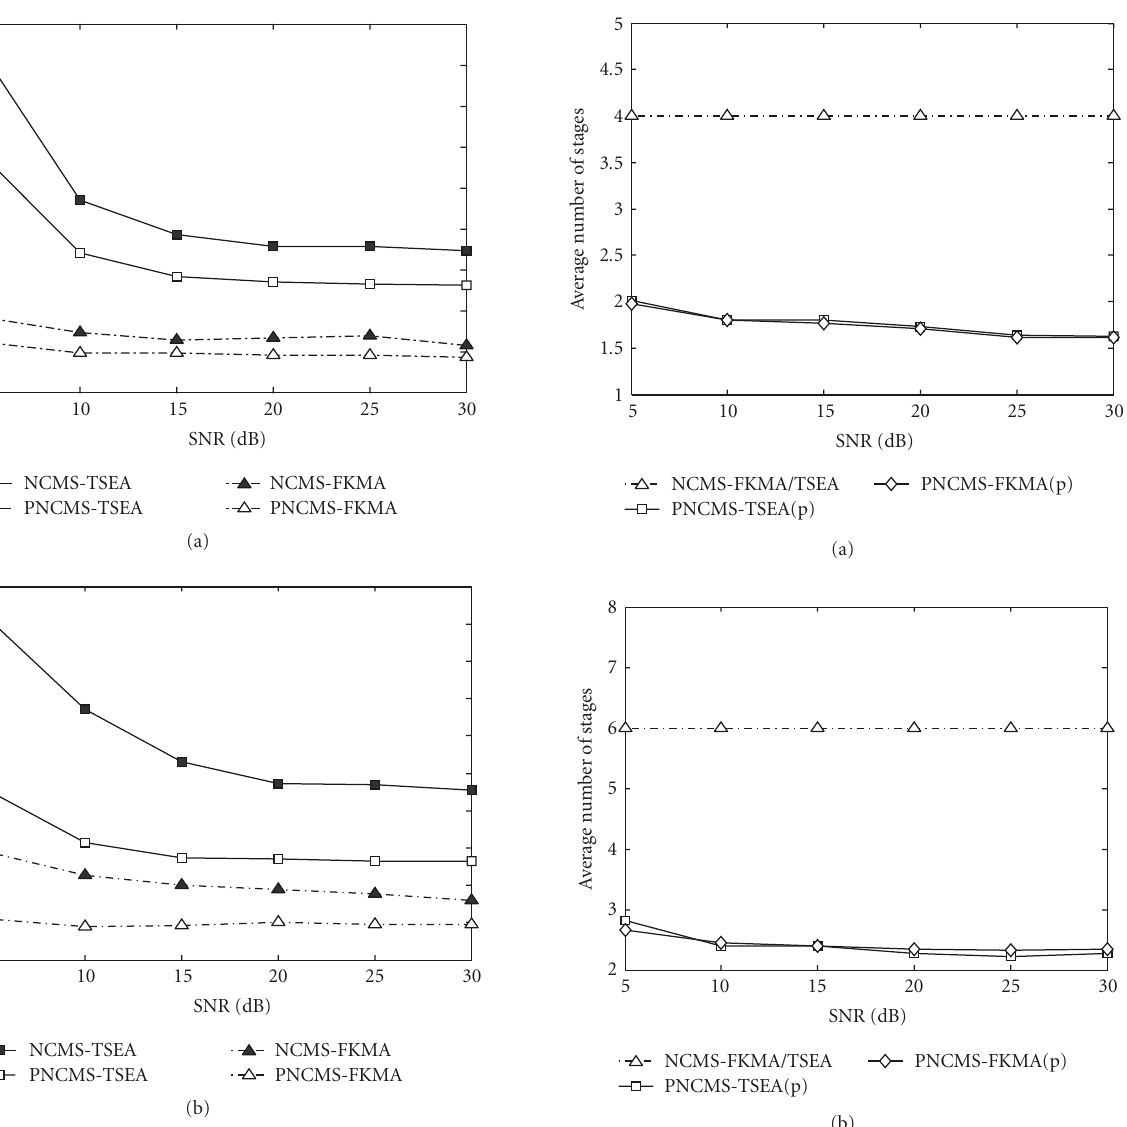
Figure 6: Complexity comparison results of Case B in Part C (average number of stages versus SNR): (a) A = A 1 and (b) A = A 3